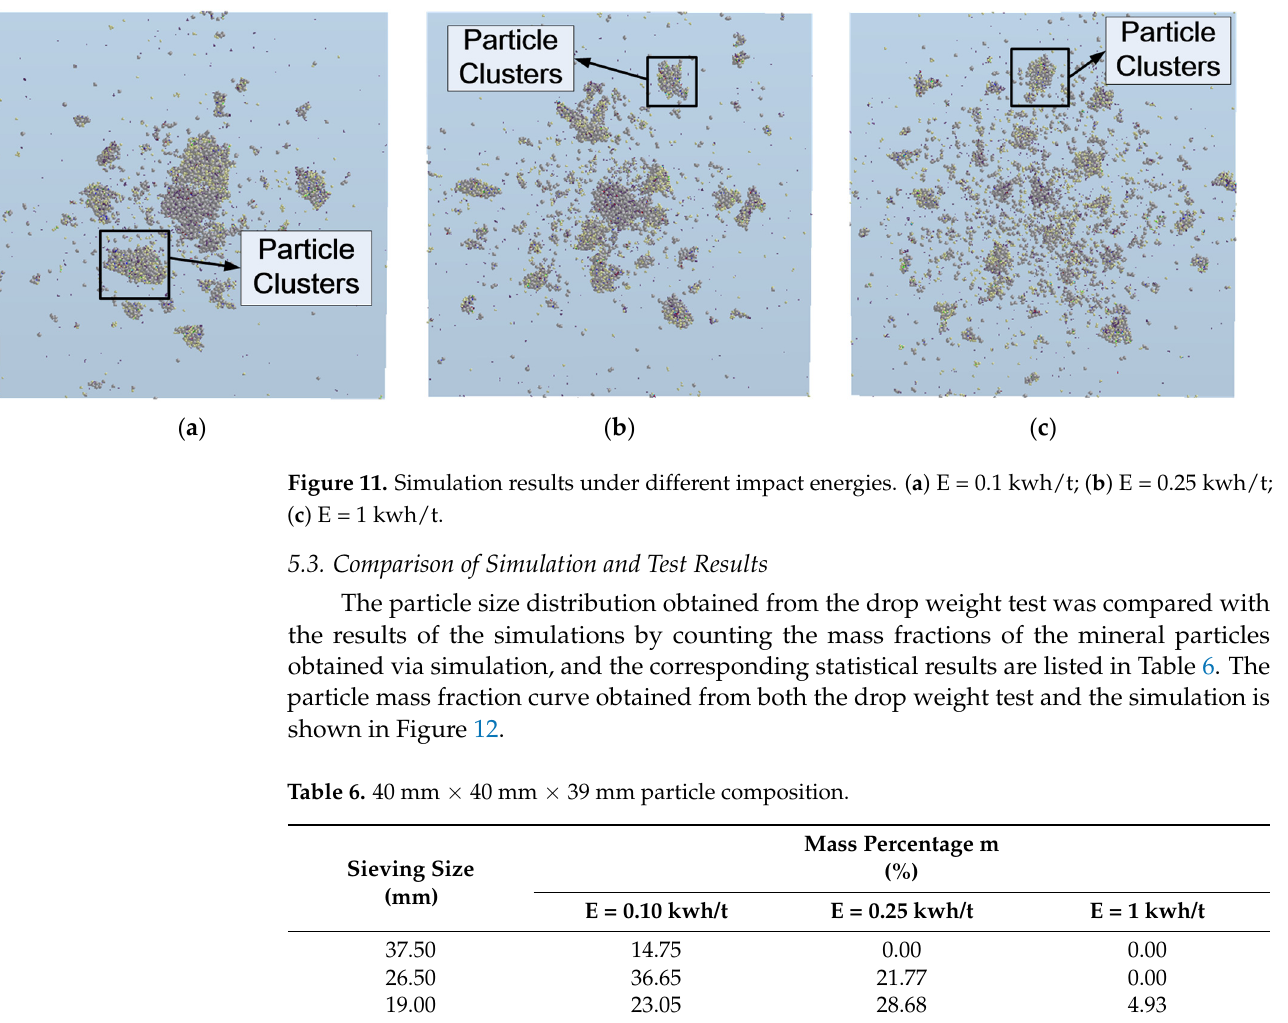
( b ) Figure 10. Bonded particle model of ore. ( a ) Particle bonding structure; ( b ) bond structure. 5.2. Discrete Element Simulation of the Mineral Crushing Process The simulation parameters in the DEM were based on the results obtained from the